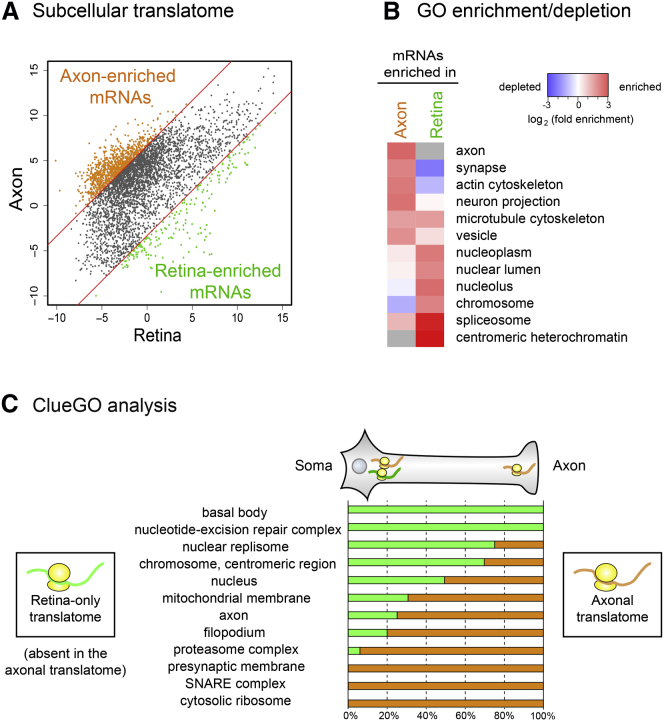
Comparison between the Axonal and Retinal Translatomes(A) Normalized mRNA levels (log2(FPKM)) between the axonal (y axis) and retinal (x axis) translatome at stage P0.5. Axon- and retina-enriched population were defined when FPKMaxon/FPKMretina > 100 and <0.1, respectively.(B) GO terms in the cellular component category. More detailed lists are in Figure S3B (gray, not detected).(C) ClueGO analysis. The left axis indicates the parental GO terms. The percentage of daughter GO terms associated with somal and axonal translatome is presented.See also Figure S3.